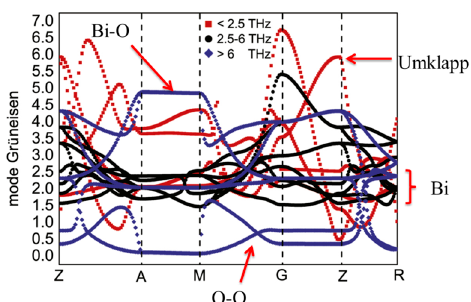
Figure 3. Mode Grüneisen parameters of BiCuSeO along the high symmetry path Z-A-M-G-Z-R-A. The mode Grüneisen parameters of acoustic branches are shown with red squares, black circles are related to the frequencies between 2.5 and 6 THz, and the phonon modes of O above 6 THz are shown with blue diamonds. Reproduced with permission from Reference [46]. Copyright 2015 IOP Publishing.